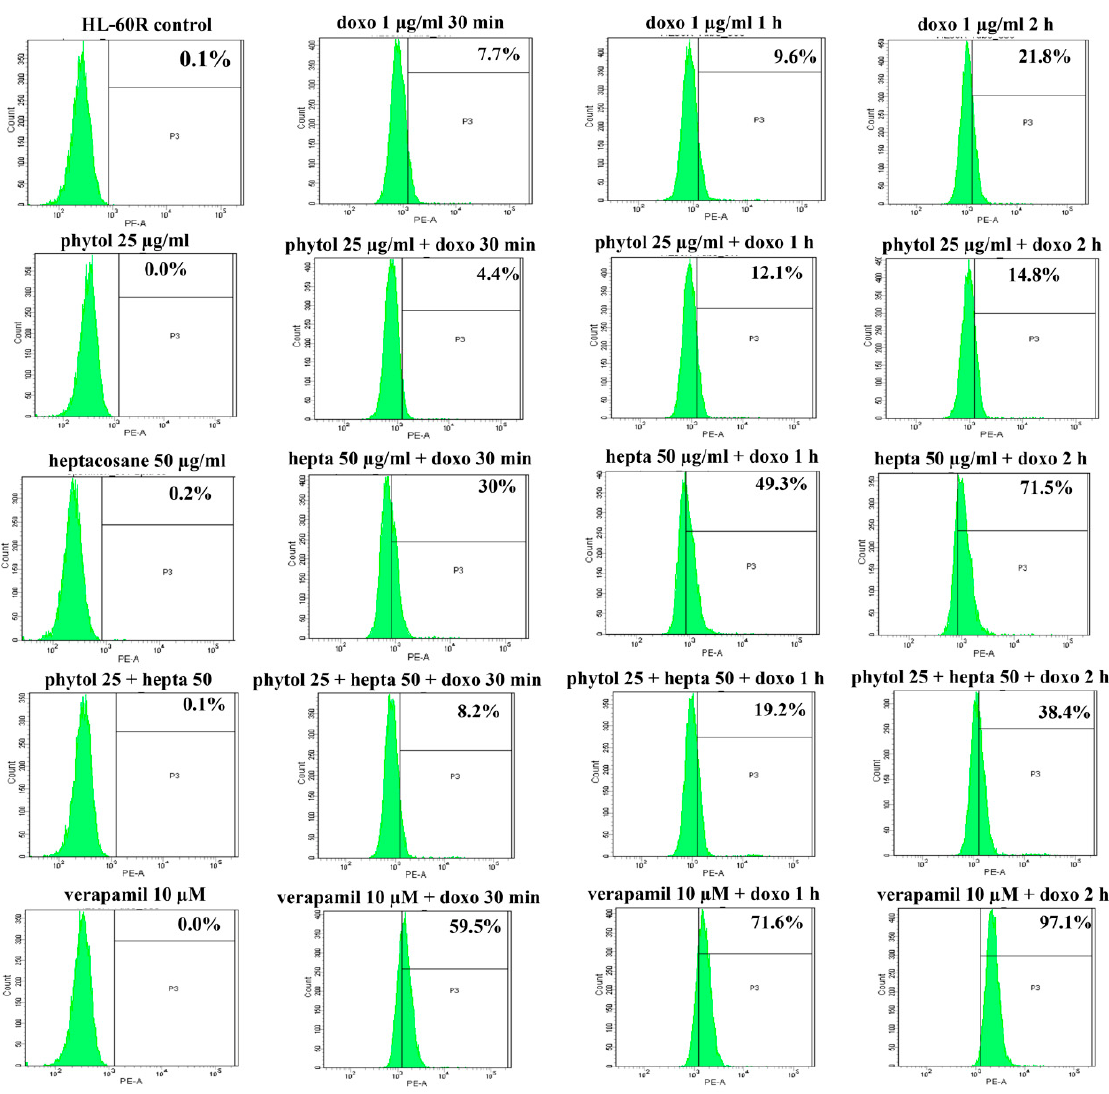
Figure 8. Effects of phytol and heptacosane on intracellular accumulation of doxorubicin in HL-60R cell line. Representative example of flow cytometry analysis of intracellular accumulation of doxorubicin (doxo; 1 µg/mL) after different times of incubation (30 min, 1 h and 2 h) in HL-60R cells pre-treated with phytol (25 µg/mL), heptacosane (hepta; 50 µg/mL), alone and in combination, or verapamil 10 µM for 24 h. Table 3. Effects of phytol and heptacosane on intracellular accumulation of doxorubicin in HL-60 and HL-60R cell lines. The cells were treated with phytol, heptacosane (hepta) alone and in combination, or verapamil. After 24 h of incubation, doxorubicin (doxo) was added at different times. The intracellular accumulation of doxorubicin was measured by flow cytometric analysis. The results are presented as percentage of fluorescence intensity (means ± standard error of three experiments).